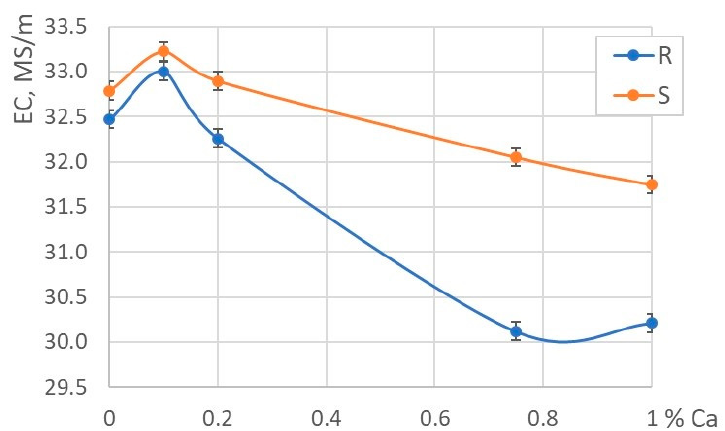
Figure 9. Electrical conductivity of Al–Ca–Fe–Si alloys containing 0.5% Fe and 0.25% Si vs. calcium content curves: R—EMC rod, S—cold rolled strip.